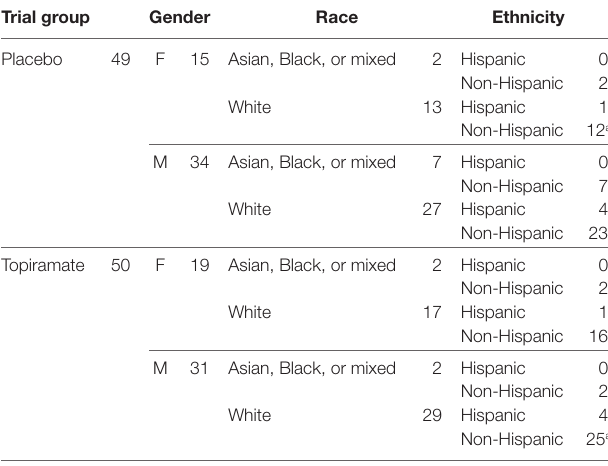
TaBle 1 | Demographic characteristics of 99 study participants with available gene expression